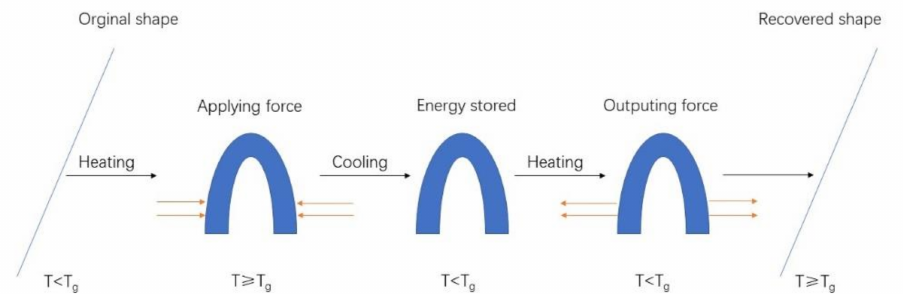
Figure 4. Schematic diagram of thermal deformation process of